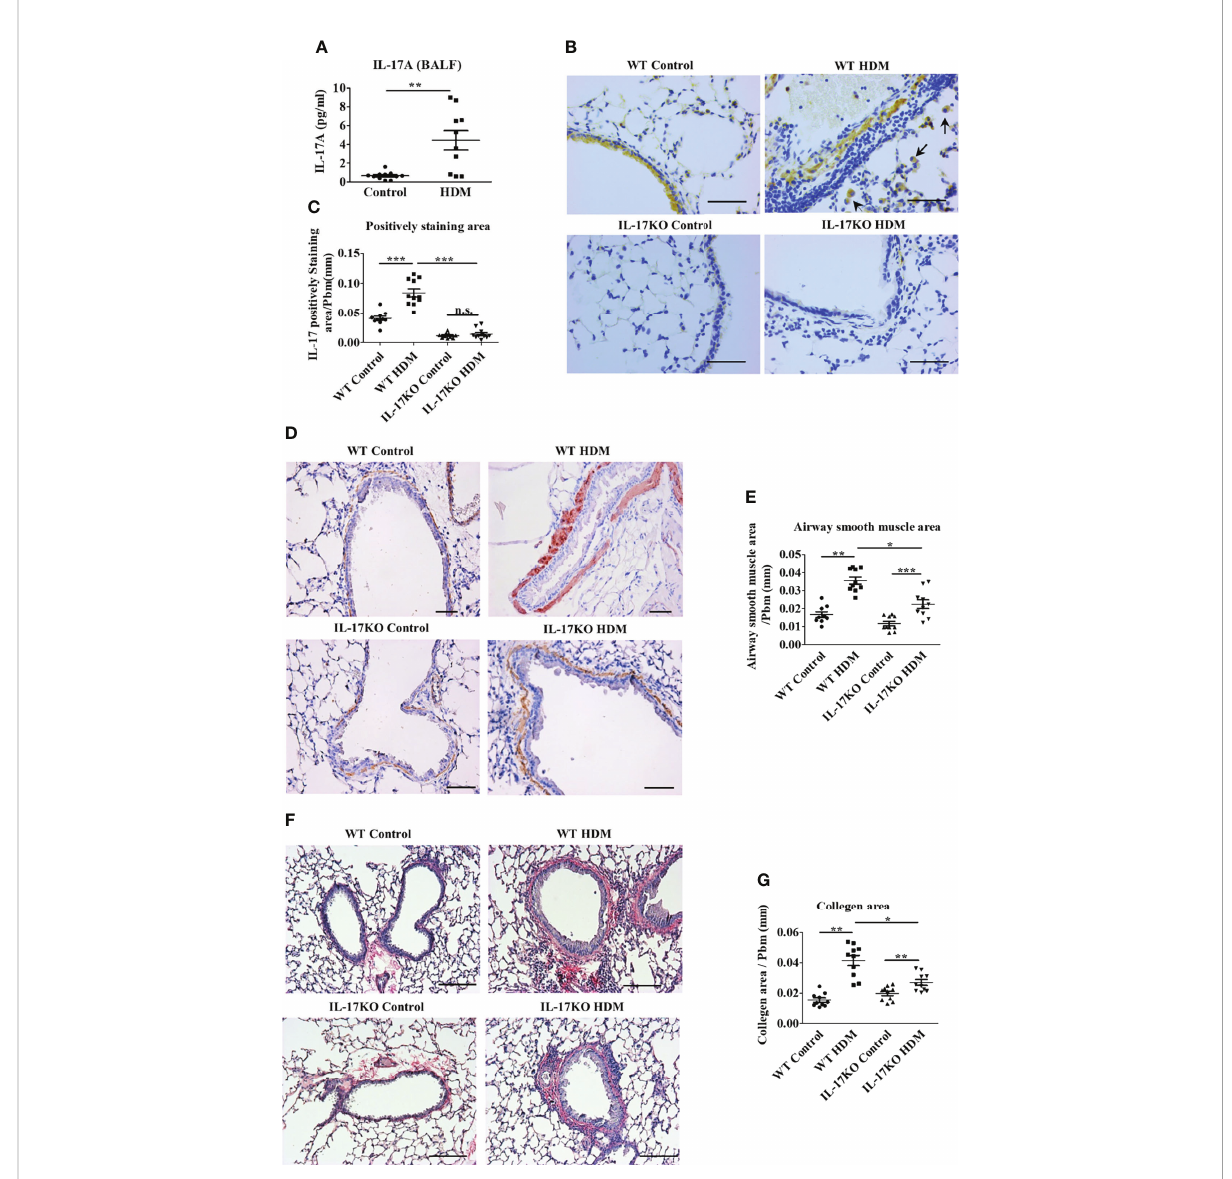
FIGURE 1 IL-17 is necessary to maintain asthmatic phenotype in HDM-induced murine model. ( A) The level of IL-17A in mouse Bronchoalveolar lavage fl uid (BALF) detected by Bio-Plex. N=10. (B, C) IHC staining (B) and quantitative analysis (C) of IL-17 positive cells in mouse lung tissue section. The brown area represents IL-17 positive. Black arrows indicate stained macrophage. Scale bar =50 m m. N=10. (D, E) IHC staining (D) and quantitative analysis (E) of airway smooth muscle mass (indicated by Alpha-Smooth Muscle Actin) in mouse lung tissue section. The brown areas represent the airway smooth muscle cells. Scale bars= 100 m m. N=10. (F, G) collagen deposition analysis in mouse lung tissue. Collagen was stained by Picro Sirius red, the color red indicates the positive staining. Scale bars=100 m m. N=10. *, P<0.05, **, P<0.01, ***, P<0.001. n.s., not statistically signi fi